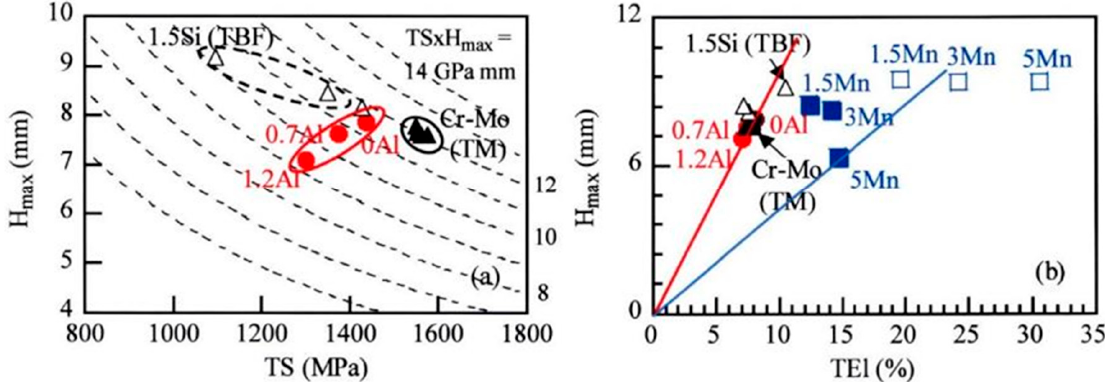
Figure 13. ( a ) Maximum stretch height–tensile strength ( H max − TS) relation in 0.20C-1.50Si-1.24Mn- 0.20Cr-0.022Al-0.0028B (0Al), 0.20C-0.73Si-1.24Mn-0.19Cr-0.72Al-9.0027B (0.7Al), and 0.20C-0.20Si- 1.24Mn-0.20Cr-1.22Al-0.0026B (1.2Al) TM steels ( ● ) [55,88], 0.2C-1.5Si-1.5Mn-(0-1.0)Cr-(0-0.2)Mo (Cr-Mo) TM steels ( ▲ ) [53], and 0.2C-1.5Si-1.5Mn-0.05Nb (1.5Si) TBF steel ( △ ) [51]. ( b ) Relationship between H max and total elongation (TEl) in these steels and 0.2C-1.5Si-(1.5-5.0)Mn (1.5Mn, 3Mn and 5Mn) M-MMn ( █ ) [59] and D-MMn ( □ ) [39] steels. ( a ) and ( b ) are produced based on references [39,51,53,55,59,88].